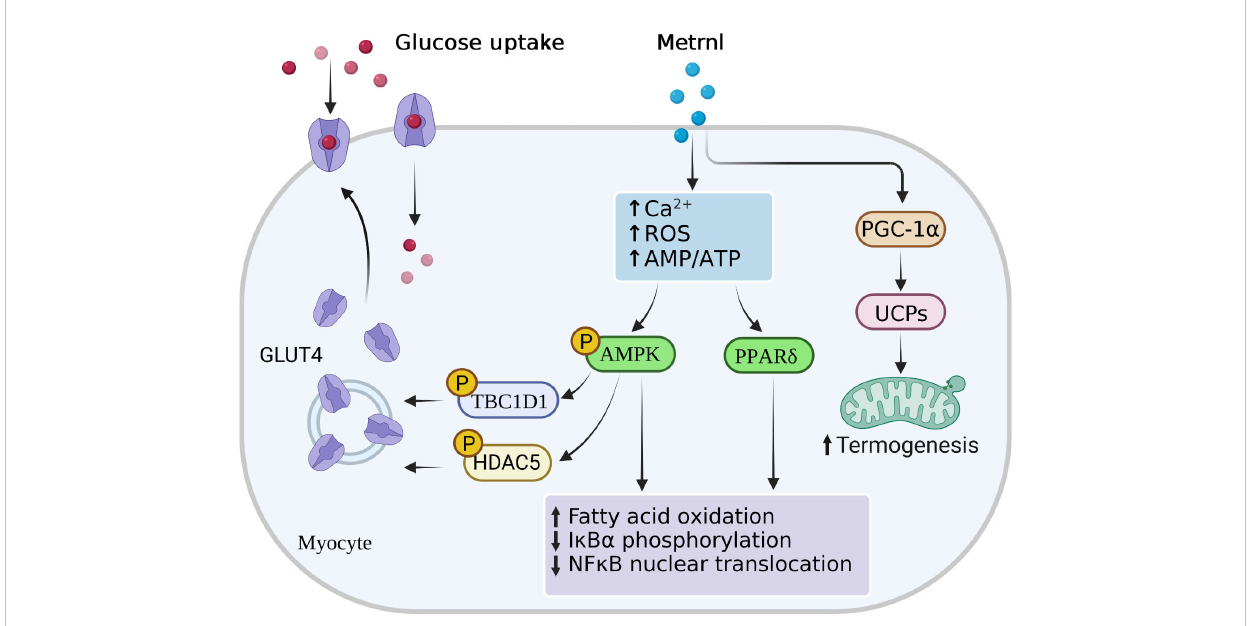
FIGURE 2 Main signal pathways of Metrnl in myocytes. Metrnl could activate AMP-activated protein kinase (AMPK) and peroxisome proliferator-activated receptor- d (PPAR- g ) signaling by increasing intracellular calcium ion, reactive oxygen species (ROS), or AMP/ATP ratio levels in skeletal muscle cells. Activation of AMPK phosphorylation stimulated phosphorylation of HDAC5 and TBC1DI, both of which resulted in the GLUT4 transcription activation and translocation from the cytoplasm to the membrane. Highly PPAR- g expressions and AMPK phosphorylation increased fatty acid oxidation, I k B a phosphorylation, and NF k B nuclear translocation. Besides, Metrnl also increased intramuscular PGC-1 a and UCPs expressions, thus promoting mitochondria